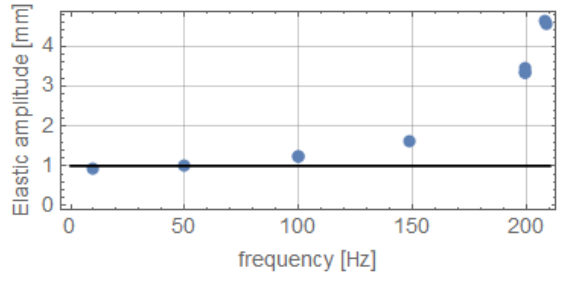
Figure 7. Amplitude of the blade oscillation measured as a function of frequency of vibration. Black line corresponds to the amplitude of a perfectly rigid